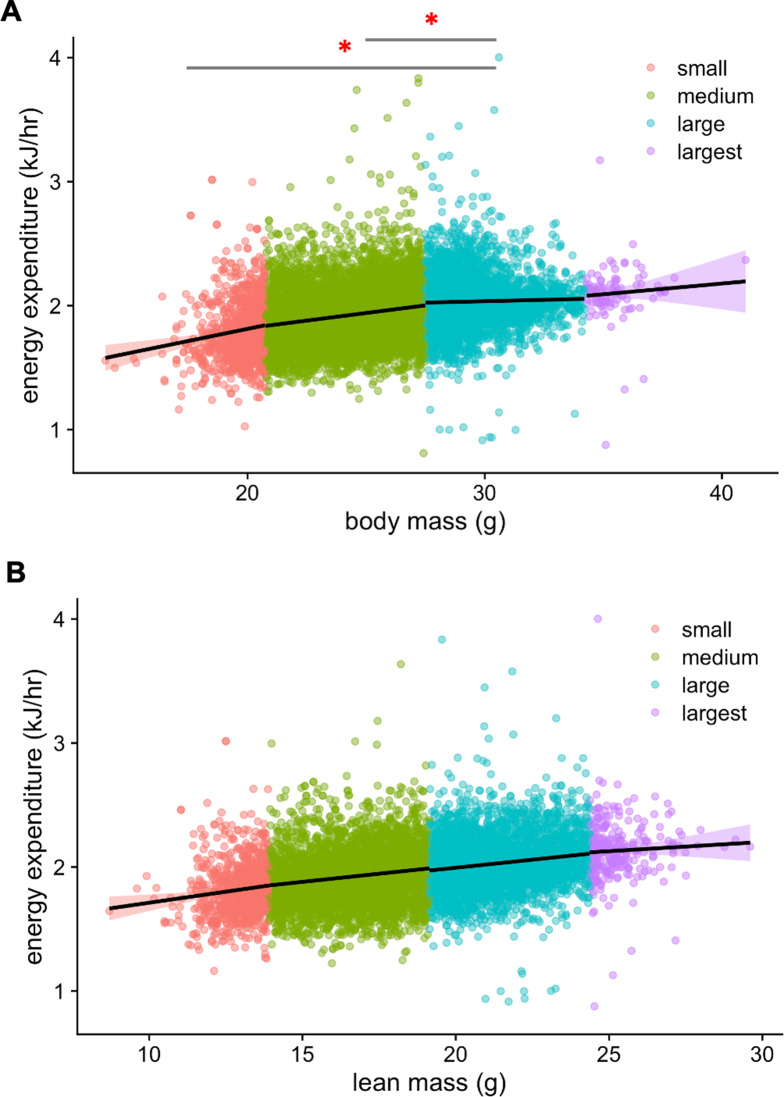
Body weight, energy balance and RER.Plots of change in energy balance (Energy intake minus EE) vs change in body weight (mass at start of experiment minus mass at end of experiment). MMPC (n = 56 males) (A). IMPC (n = 3738 males and 2140 females) (B).